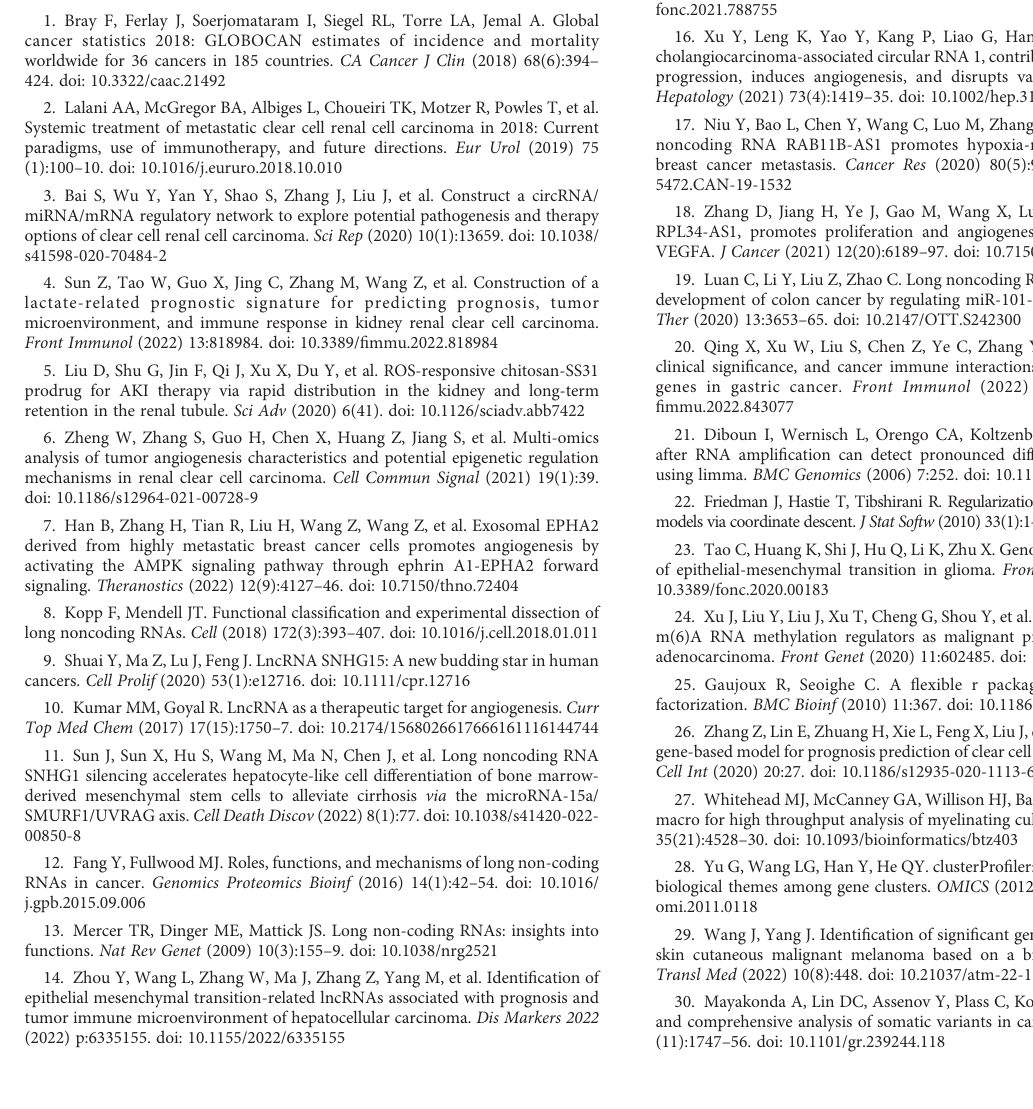
SUPPLEMENTARY FIGURE 2 Prognostic signature of clinical evaluation. A heat map (A) along with a scatter diagram showing that grade (B) , stage (C) , T stage (D) , N stage (E) , and M stage (F) were signi fi cantly associated with the risk score, while age (G) and gender (H) were not signi fi cantly related to the risk score.